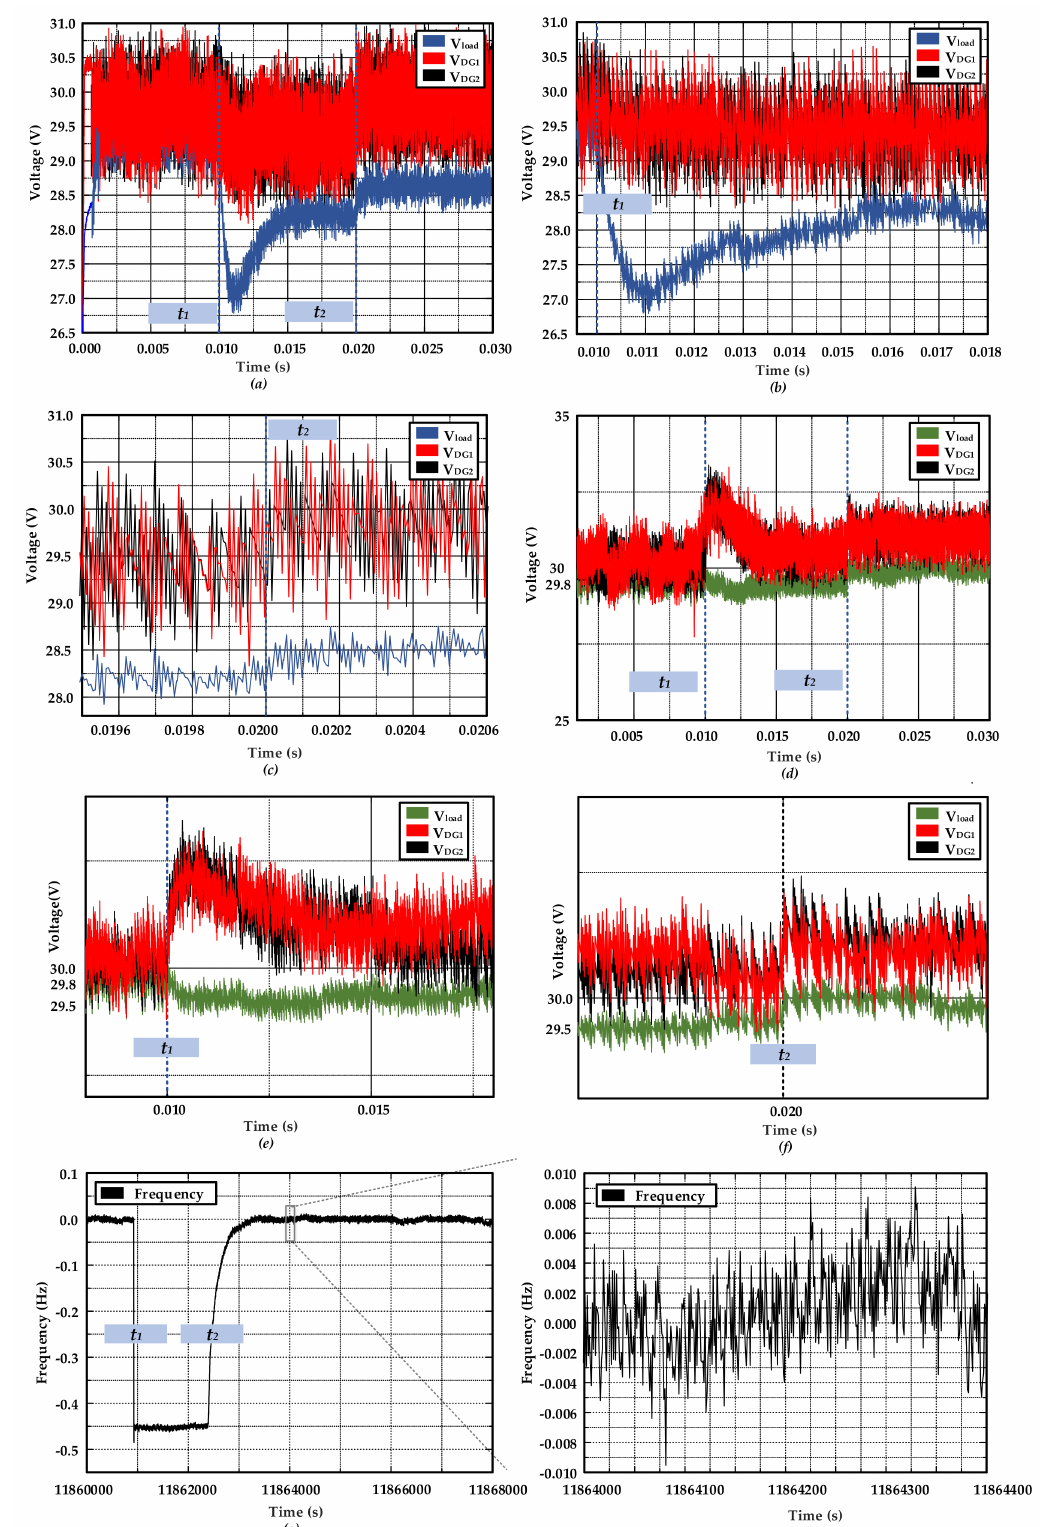
Figure 8. Experimental results. ( a ) Behavior of load voltage and inverter terminal voltages with conventional control scheme. ( b ) Disturbance load jX d1 /R d1 added at t 1 . ( c ) Voltage regulation with conventional control scheme. ( d ) Behavior of load and inverter terminal voltages with proposed control scheme. ( e ) Disturbance load jX d1 /R d1 added at t 1 . ( f ) Voltage regulation with proposed control scheme. ( g ) Frequency regulation. ( h ) Magnified Frequency Regulation